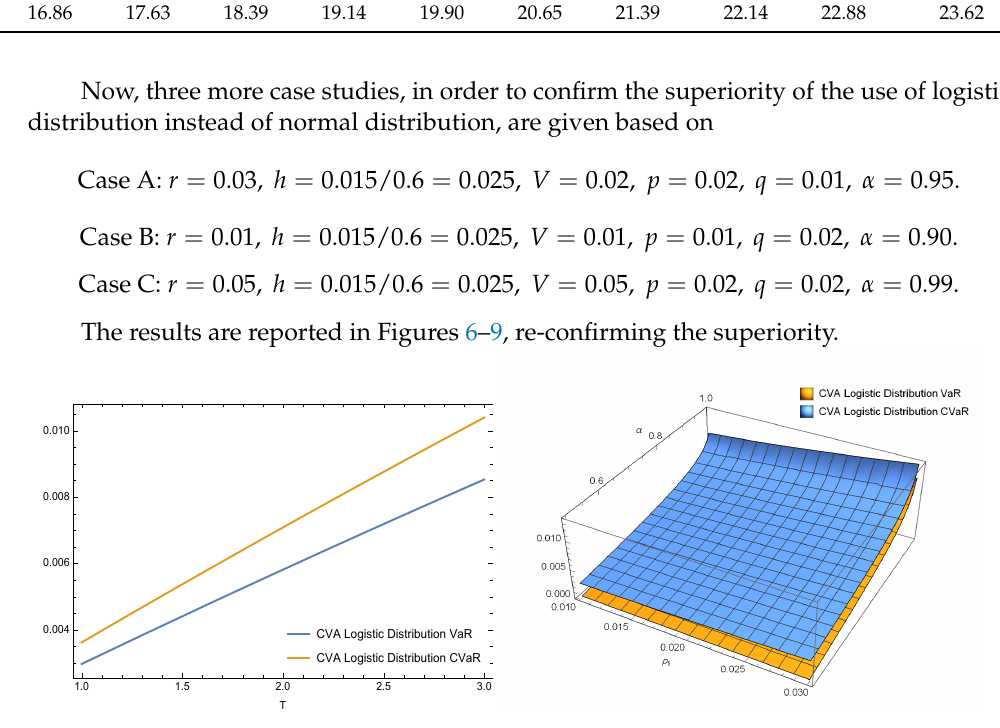
Figure 6. VaR and CVaR when both the credit spread and the EPE are given by the logistic distribution. When only T changes in left . When two other parameters p 1 and α change in right .